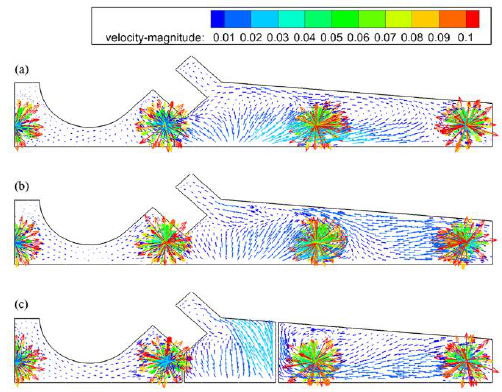
Figure 19. Velocity fields of the bottom surface: ( a ) case A0, ( b ) C1, ( c ) C5.